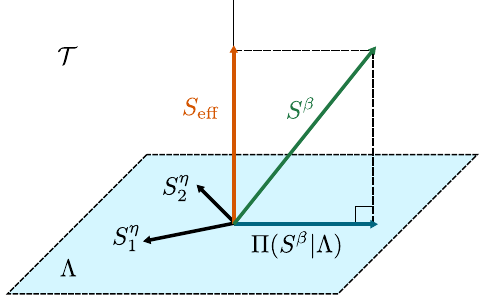
FIG. 10. The whole space in the picture represents the tangent space T . Λ is the nuisance tangent space spanned by the nuisance tangent set f S η g . S β is the score with respect to the parameter of interest. The efficient score S is S β minus its projection eff Π ð S β j Λ Þ . The result is orthogonal to Λ